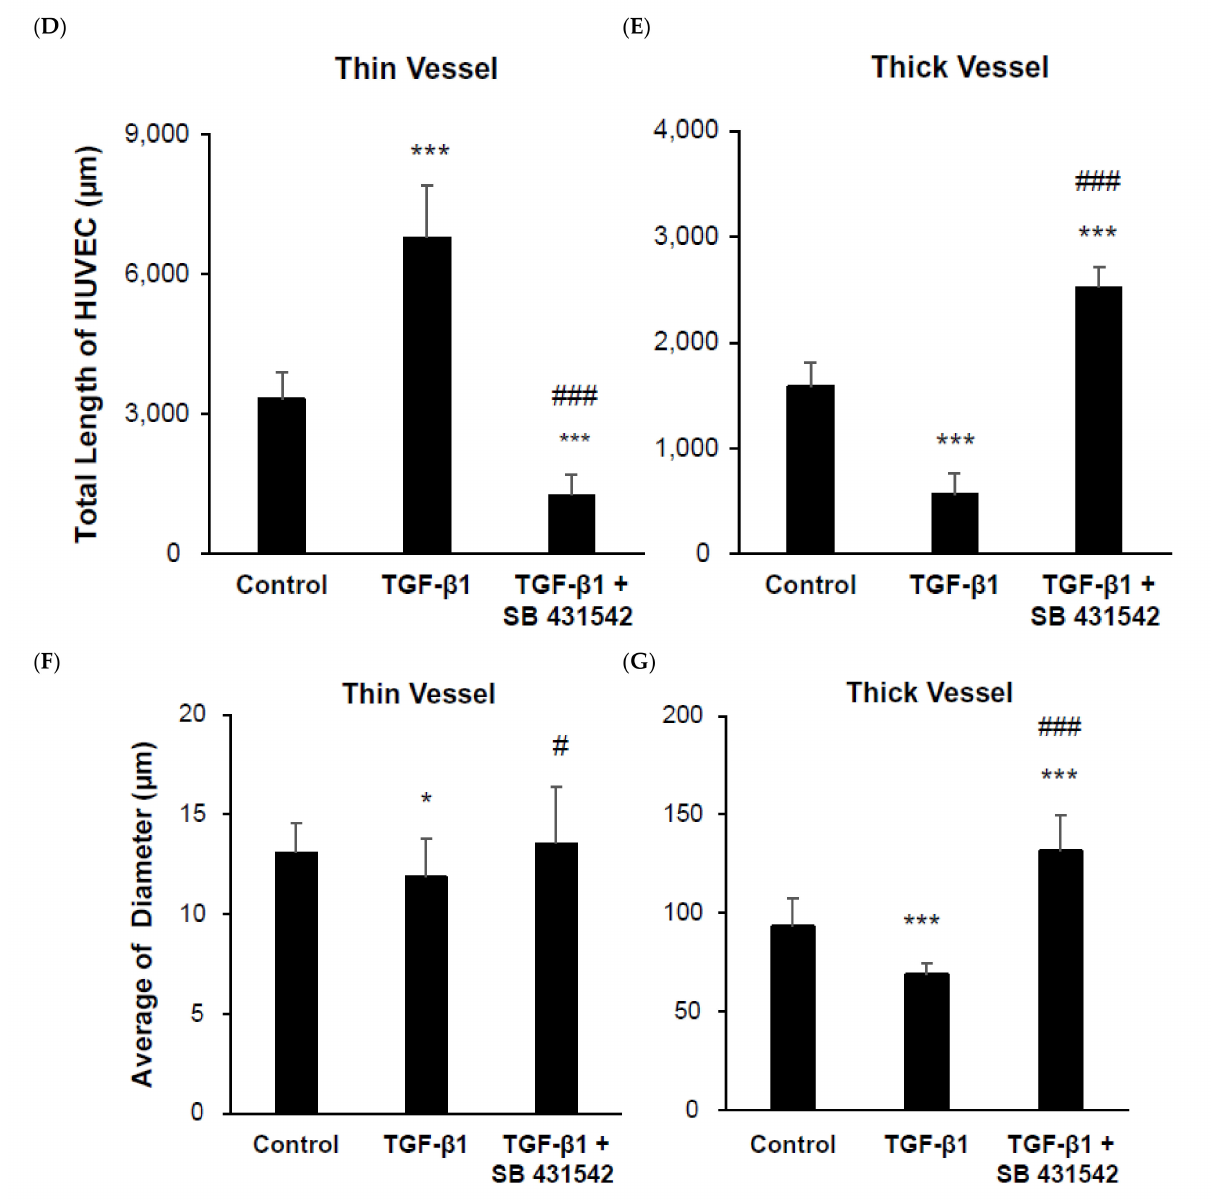
Figure 4. Alteration of 3D-cultured HK-2 and HUVECs with primary renal fibroblasts. Total cells were plated at a density of 5 × 10 5 per 3D chip and stimulated with 5 ng/mL TGF- β 1 or 10 µ m inhibitor (SB 431542) for 24 h and fixated with 4% paraformaldehyde. ( A ) Cells in the 3D chip were stained with anti- α -SMA and anti-cytokeratin-8. The expression of α -SMA ( a – c ) was increased and KRT8 ( d – f ) expression was decreased by TGF- β 1 (5 ng/mL) significantly. The total length of the HUVECs: thin vessels were dramatically increased and thick vessels were decreased by TGF- β 1 ( D , E ). The diameter was decreased for thin and thick vessels ( F , G ). These results were reversed by the inhibitor SB431542. Scale bars in micrographs indicate 100 µ m. * p < 0.05, ** p < 0.01, and *** p < 0.001 versus the control group; # p < 0.05, ## p < 0.01, and ### p < 0.001 versus the TGF- β 1 group. Each value represents three technical replicates of each of the three biological replicates. Thin vessels mean a length shorter than 50 µ m and thick vessels represent a length longer than 50 µ